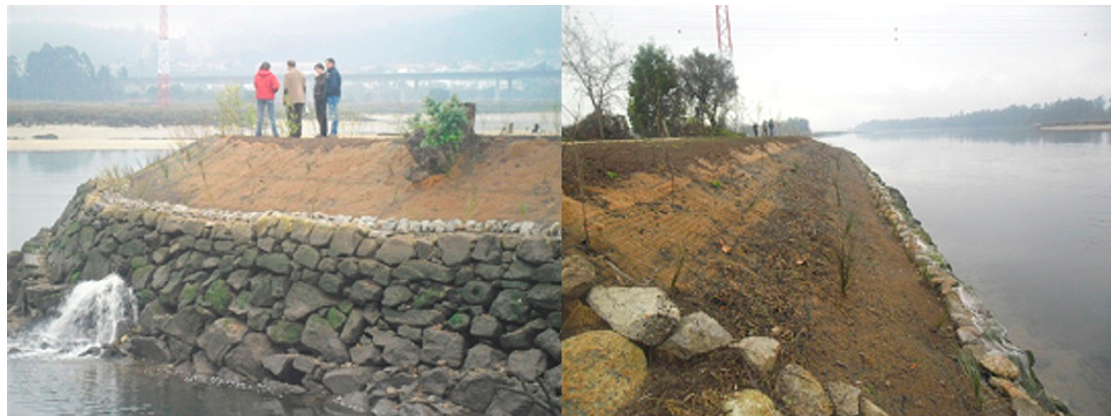
Figure 7. Rip-rap (left) and geogrid disposal (right) in the Portuzelo site (2014).